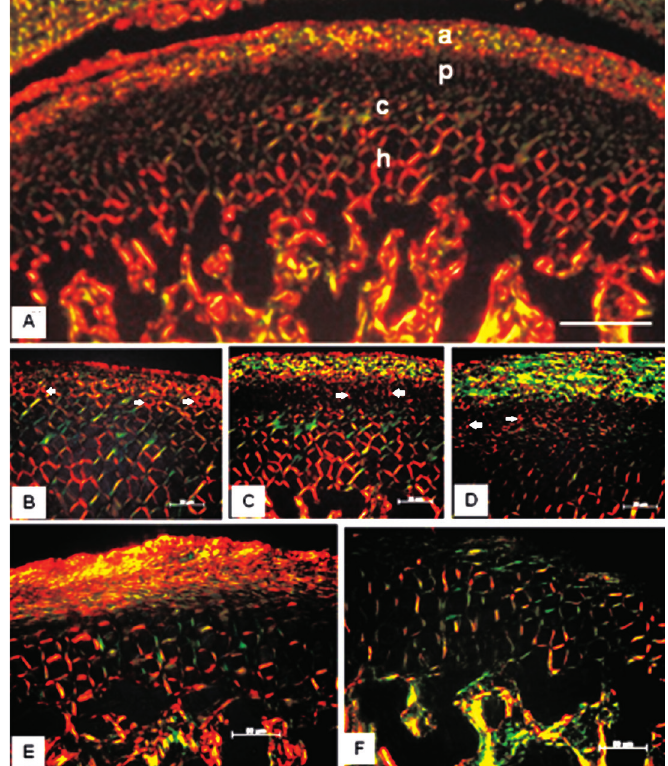
Figure 2- Sagittal mandible condylar process cartilage (CP) of Wistar rats. Picro-sirius red under light polarized coloring method. Collagen type I (yellow, orange and red) and III (green) detection. A: Articular layers (a), pre-chondroblastic (p), chondroblastic (c) and hypertrophic (h) of the CP; B - F (40X): Distribution of collagen types I and III in the matrix of fibrous cartilage of CP in groups N, nourished from day 21 to day 60; U, undernourished from day 21 to day 60; R, renourished from day 21 to day 60; NN, nourished until day 100; and RR, renourished from day 21 to day